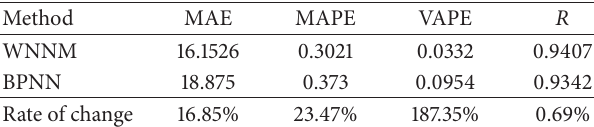
Table 4: Comparison of performance between WNNM and BPNN. Method MAE MAPE VAPE 𝑅 WNNM 16.1526 Rate of change 16.85%